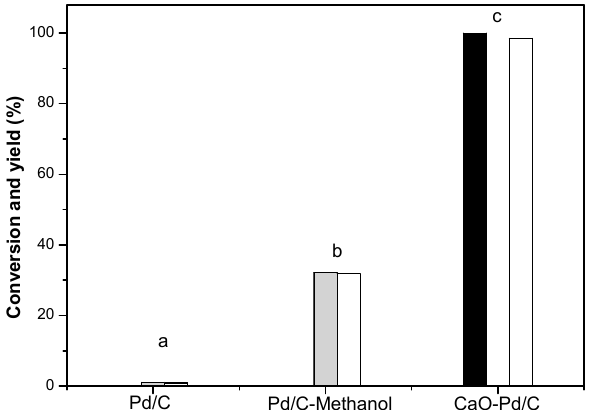
Figure 3. Cyclopentanone conversions (black columns), 2,5-bis (2-furylmethylidene)-cyclopentanone conversion (gray columns) and carbon yields of 2,5-bis(furan-2-ylmethyl)-cyclopentanone (white columns) over Pd / C catalysts. Experimental conditions: 10 h, 423 K, and 4.0 MPa H 2 ; ( a ) 2.40 g 2,5-bis(2-furylmethylidene)-cyclopentanone, 0.05 g Pd / C; ( b ) 2.40 g 2,5-bis (2-furylmethylidene)-cyclopentanone, 0.05 g Pd / C and 10.0 mL methanol; and ( c ) 0.84 g cyclopentanone (10 mmol), 1.92 g furfural (20 mmol); 0.05 g CaO and 0.05 g metal catalyst were used in the tests.